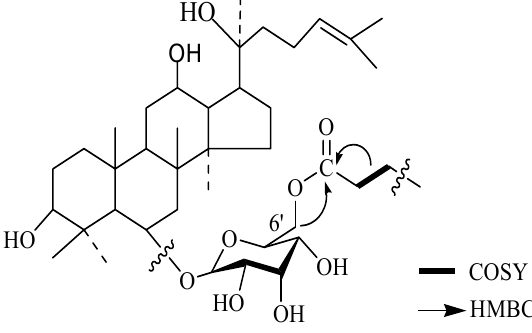
Figure 3. Partial HMBC and COSY correlation of the synthetic compound.